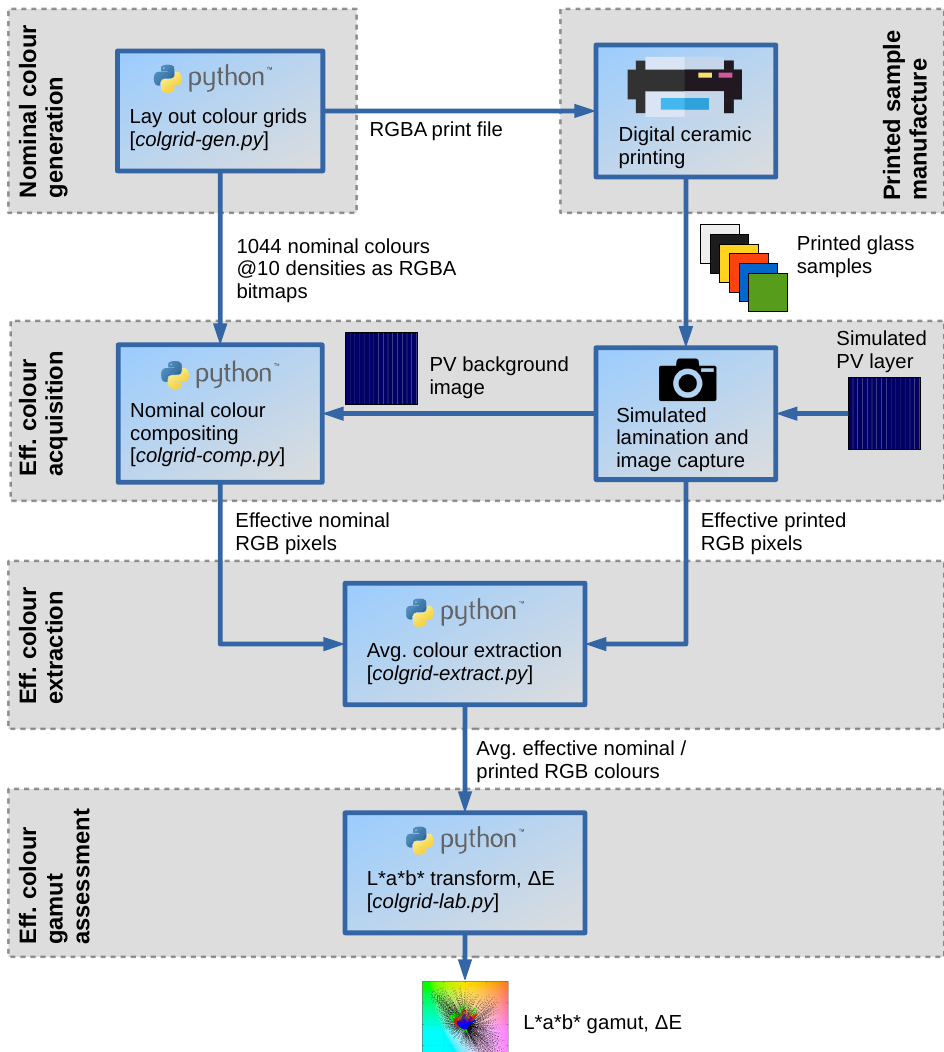
Figure 1. Overview of our coloured photovoltaic (PV) rendering analysis